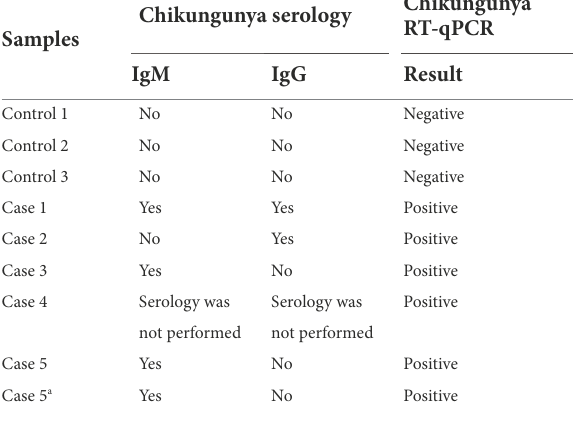
TABLE 1 Serological and molecular